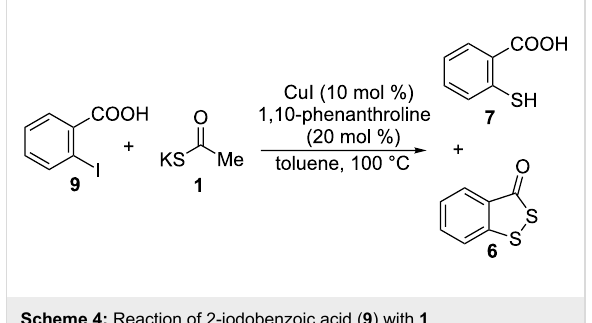
Scheme 4: Reaction of 2-iodobenzoic acid ( 9 ) with 1